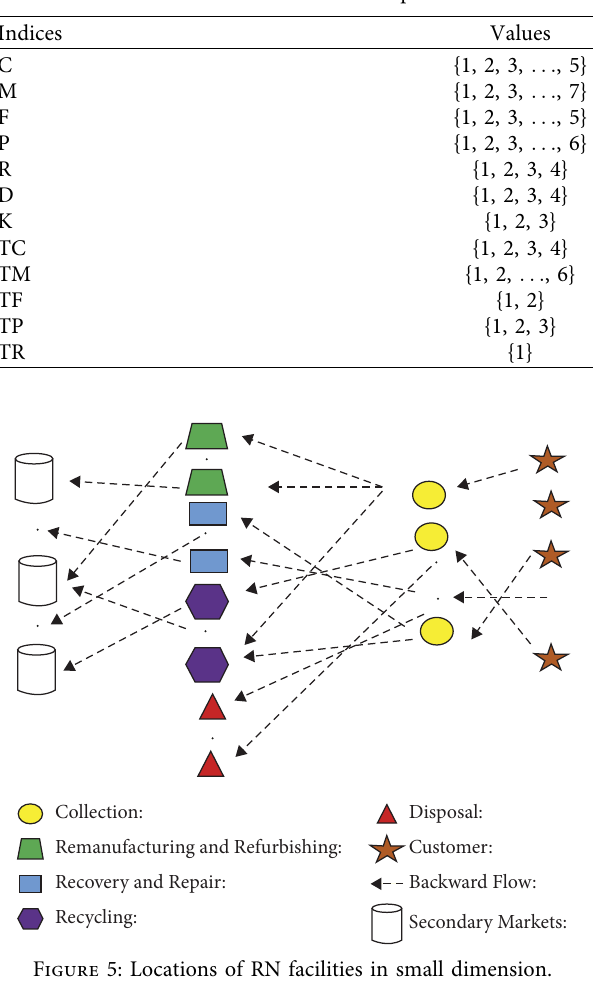
Figure 4: Graphic depiction of the Pareto solutions. Table 3: Number of facilities and transportation mode.